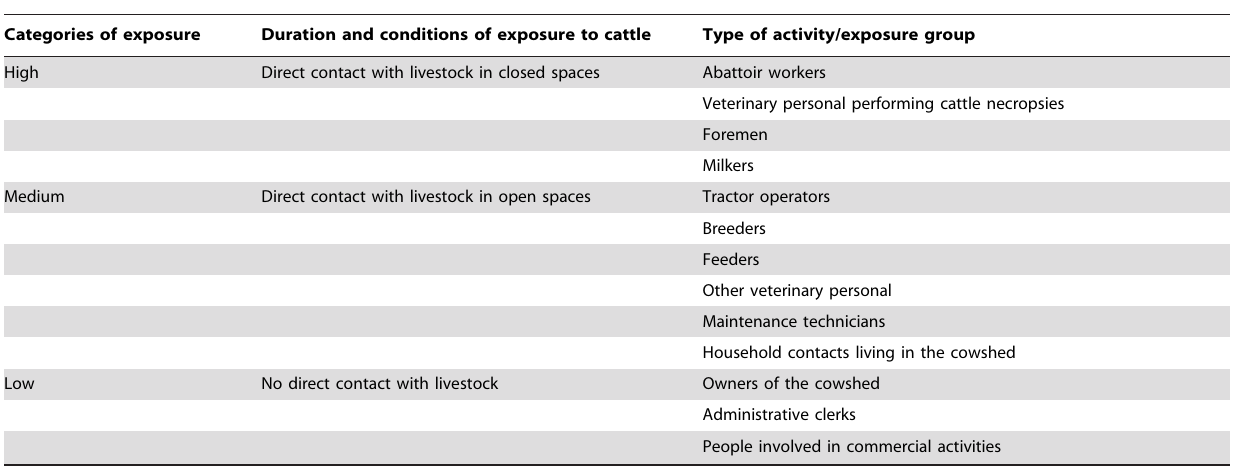
Table 1. Categories of exposure to cattle among study population according to duration and conditions of exposure to cattle.